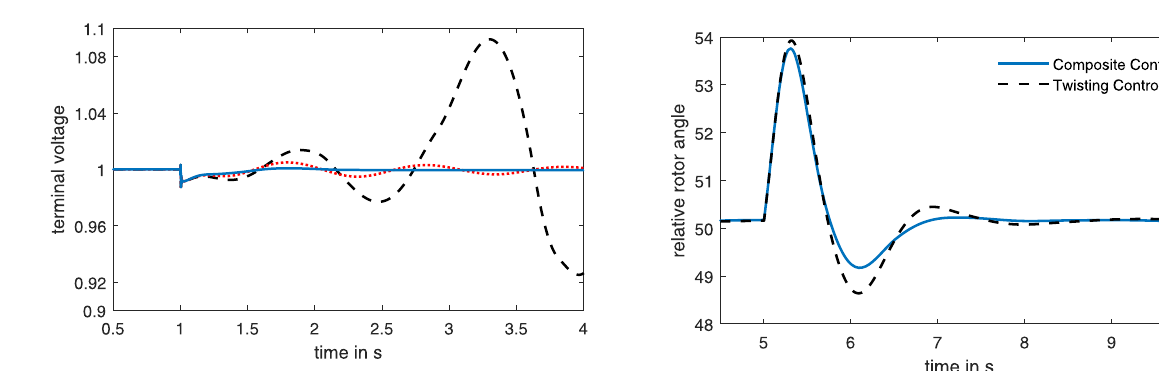
Fig. 14 Relative rotor speed in a noisy